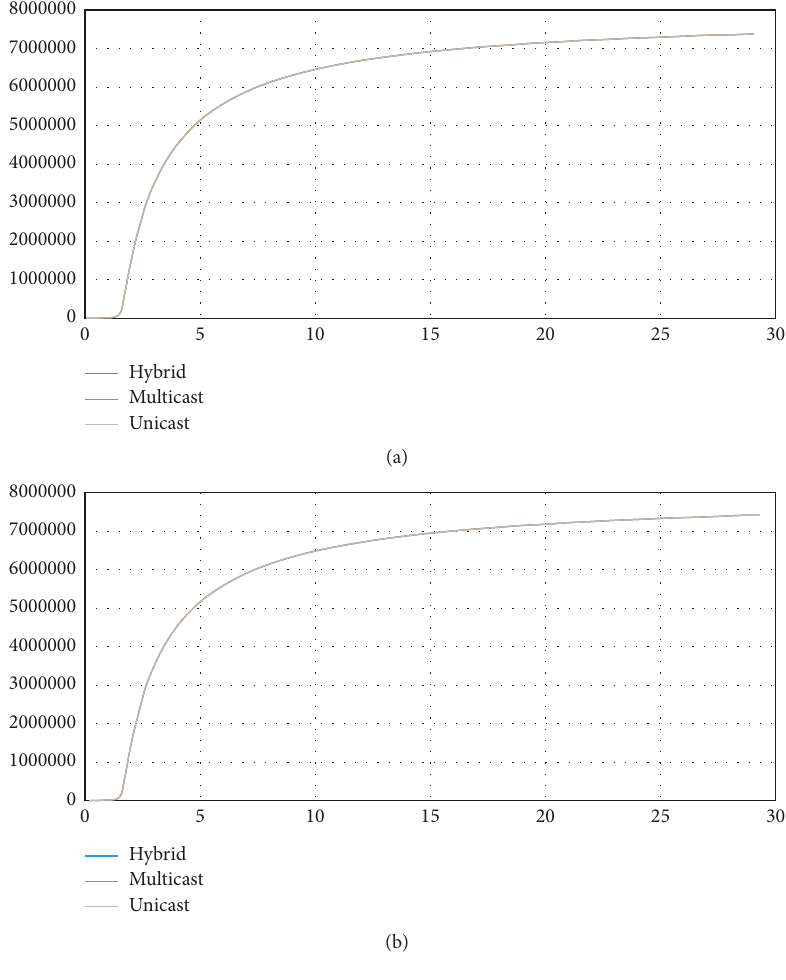
Figure 5: (a) IPTV traffic received. (b) IPTV traffic